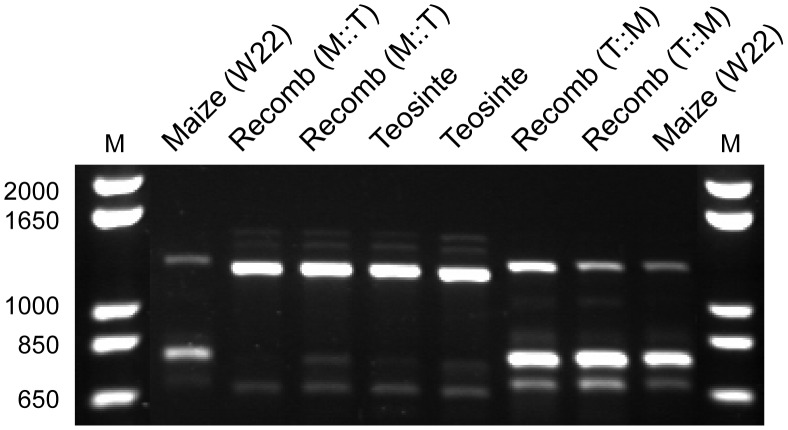
Agarose gel image showing RT-PCR products for gt1.Lanes show the maize (W22) allele, teosinte allele, recombinant allele with the maize control region and teosinte coding region (M:T), and recombinant allele with the teosinte control region and maize coding region (T:M). The outer two lanes are molecular size markers with the sizes in bp indicated.